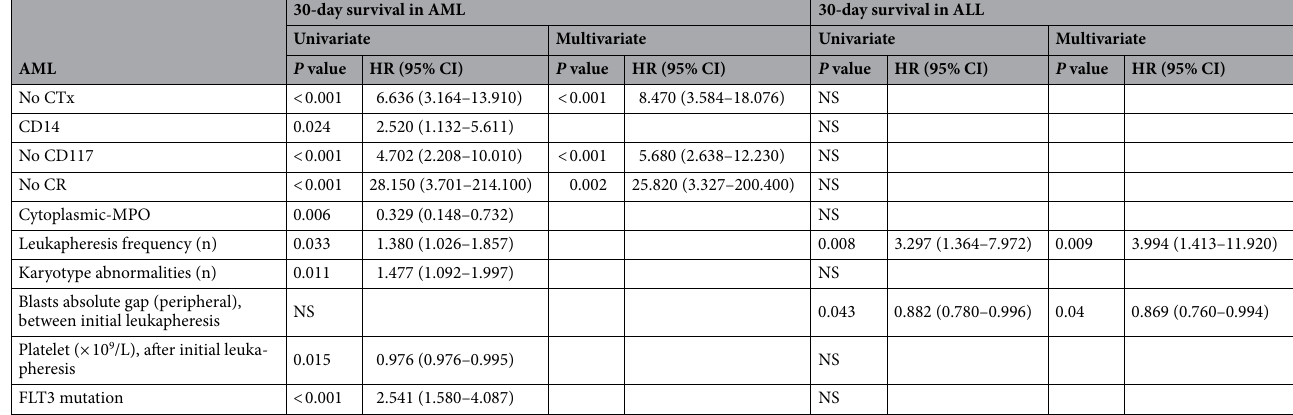
Table 3. Prediction for 30-day survival using univariate and multivariate logistic regression in acute myeloid leukaemia (AML), acute lymphoblastic leukaemia (ALL) groups. HR hazard ratio, CTx chemotherapy, NS not